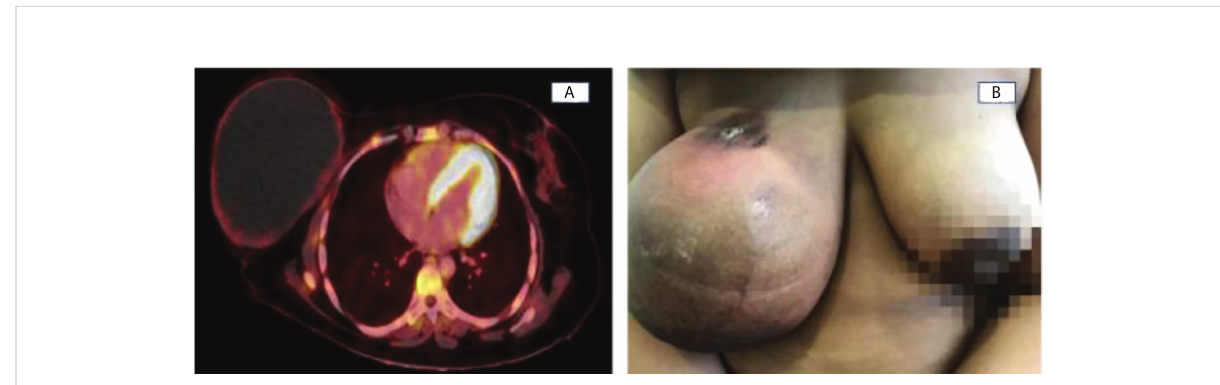
FIGURE 3 (A) Complete metabolic response due to persistence of a voluminous cystic left breast lesion with a thin wall of low uptake of FDG ((SUVmax:2,21) and complete disappearance of ipsilateral locoregional lymphadenopathy. (B) After completing NAC, the nodule at the union of the upper quadrants